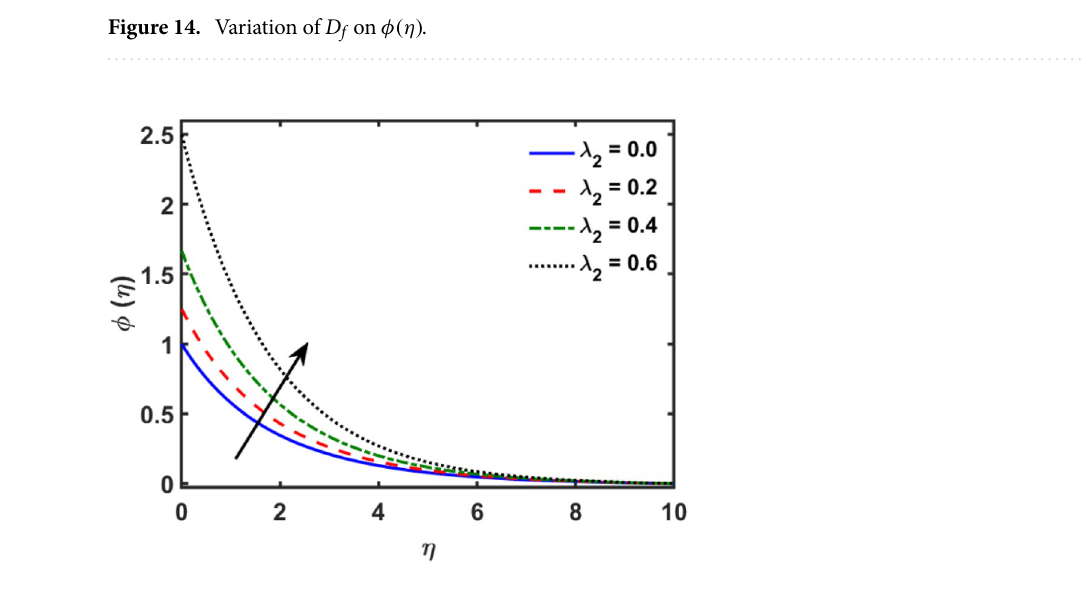
Figure 15. Variation of (cid:31) 2 on φ(η)